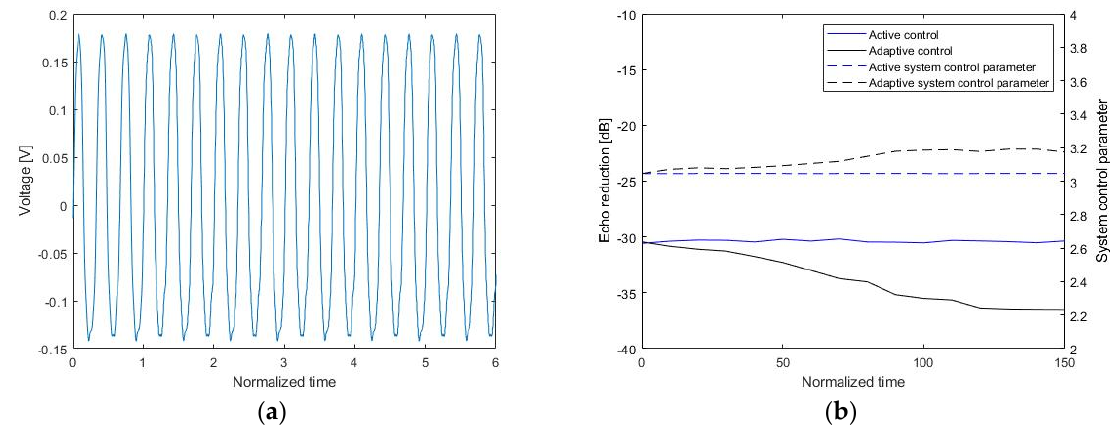
Figure 15. Use of active noise control: ( a ) a continuous input signal and ( b ) the echo reduction rate and system control parameter.